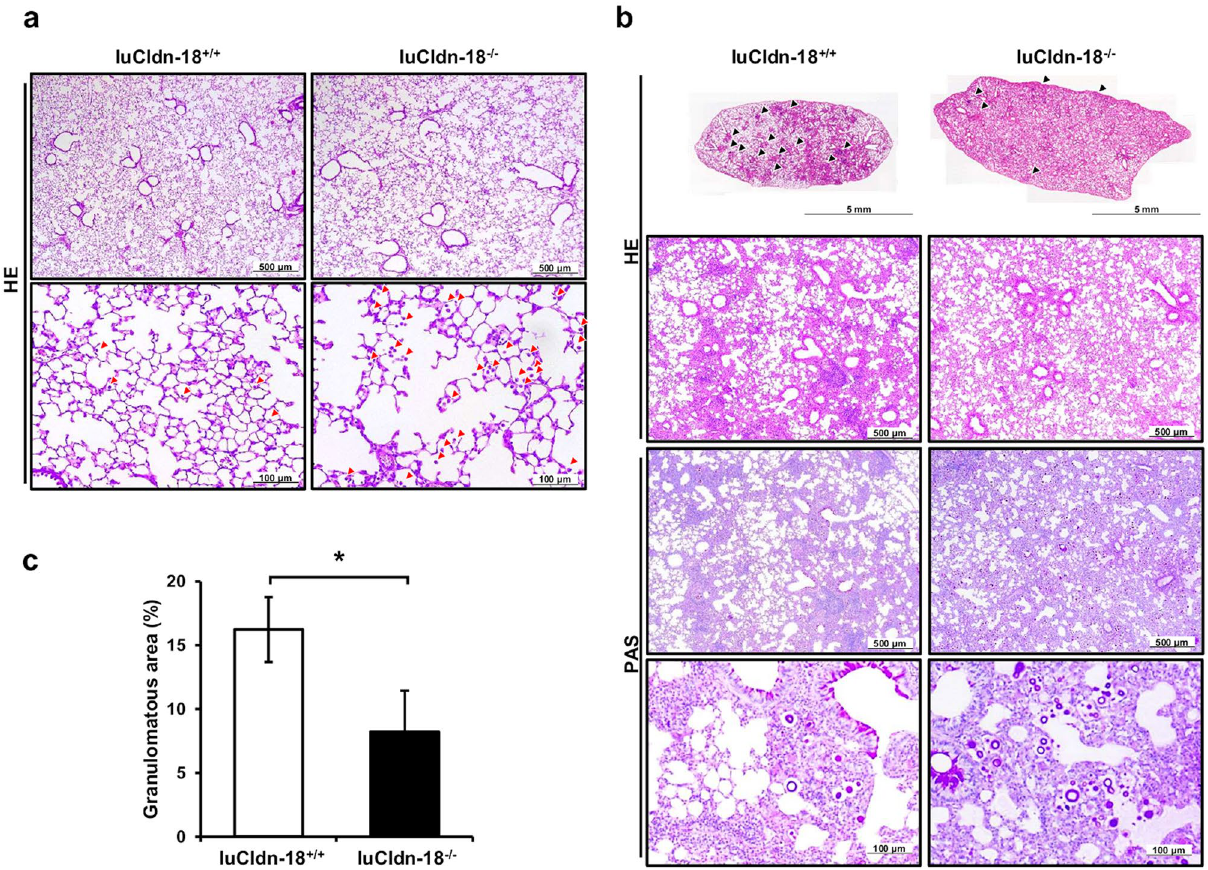
Figure 2. Effects of luCldn-18 deficiency on pulmonary histological findings after infection with C. deneoformans. ( a ) Lung sections of uninfected luCldn-18 +/+ (n = 3) and luCldn-18 −/− mice (n = 3) were stained with H-E and observed under a light microscope at ×40 (upper panels) and ×200 (under panels) . Red arrows show alveolar macrophages. ( b ) luCldn-18 +/+ and luCldn-18 −/− mice were infected intratracheally with C. deneoformans. Sections of the lungs on day 14 post-infection were stained with H-E or PAS and observed under a light microscope. Original magnifications: upper panels, the upper lobe of the left lungs; middle panels, ×40; lower panels, ×200. Representative pictures are shown. Black arrows show granulomas. ( c ) The proportions of granulomatous areas were calculated. Each column represents the mean ± SD of 3 mice. *, p <